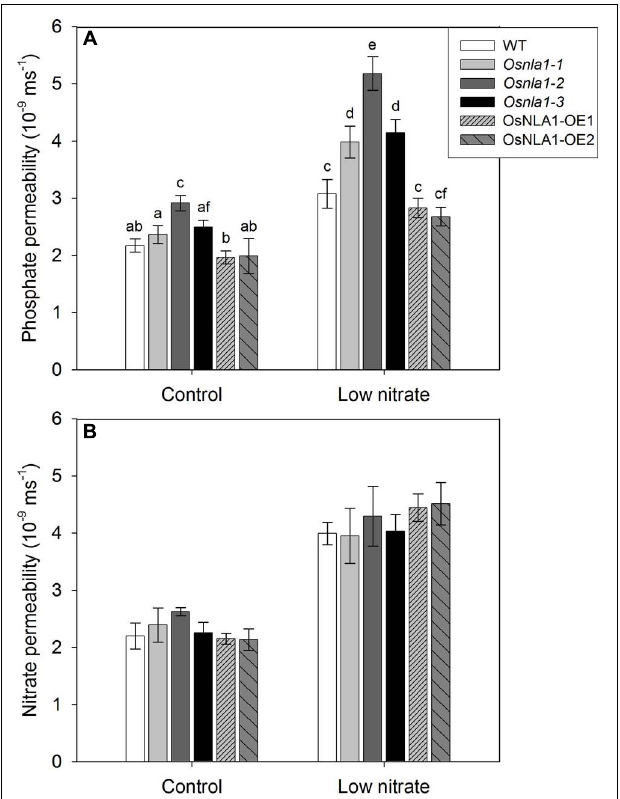
FIGURE 6 | Permeability of roots ( Ps r ) for Pi and nitrate of OsNLA1 transgenic lines under low and optimum nitrate levels. The Pi and nitrate permeability was measured using a root pressure probe for adventitious roots of plants grown in hydroponics for 4 weeks in either optimum/control (300 µ M), or low (30 µ M) nitrate levels. (A) Comparison of Pi permeability of roots grown at optimum and low nitrate levels. In all genotypes, low nitrate treatment enhanced Pi permeability of roots, but more pronounced in knockdown lines ( osnla1-1 , osnla1-2, and osnla1-3 ). (B) Comparison of nitrate permeability of roots grown in different nitrate levels. All genotypes have the same permeability at each nitrate treatment. Plants grown in low nitrate had enhanced nitrate permeability of roots in all genotypes. Different letters indicate significant differences at P ≤ 0.05 level (ANOVA, LSD test). Data are means ± SD of ten replicates ( n =